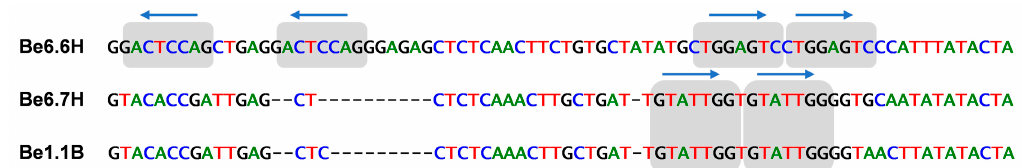
Figure 2. Iteron sequences found in the intergenic region of the clones Be6.6H, Be6.7H, and Be1.1B. Clone Be6.6H displayed different iterons as compared to clones Be6.7H and Be1.1B. Sequences in light grey boxes represent iteron sequences. Right arrows indicate forward repeats of iterons, and left arrows indicate inverted repeats of the iterons.